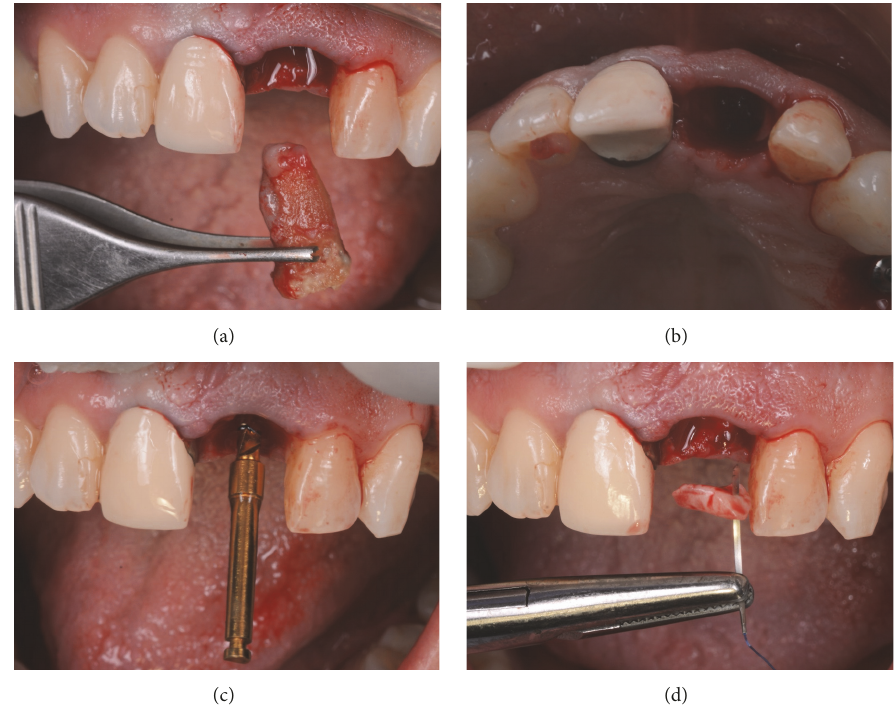
Figure 3: Surgery. The nonrestorable tooth is extracted (a) and the socket is carefully debrided (b), in order to remove all infected tissue; then, the implant site is prepared with sequential drills, exceeding the alveolar apex 3-4mm (c) and before to place the implant, a connective tissue graft is harvested from the palate, in order to thicken the soft tissues in the delicate buccal area (d).